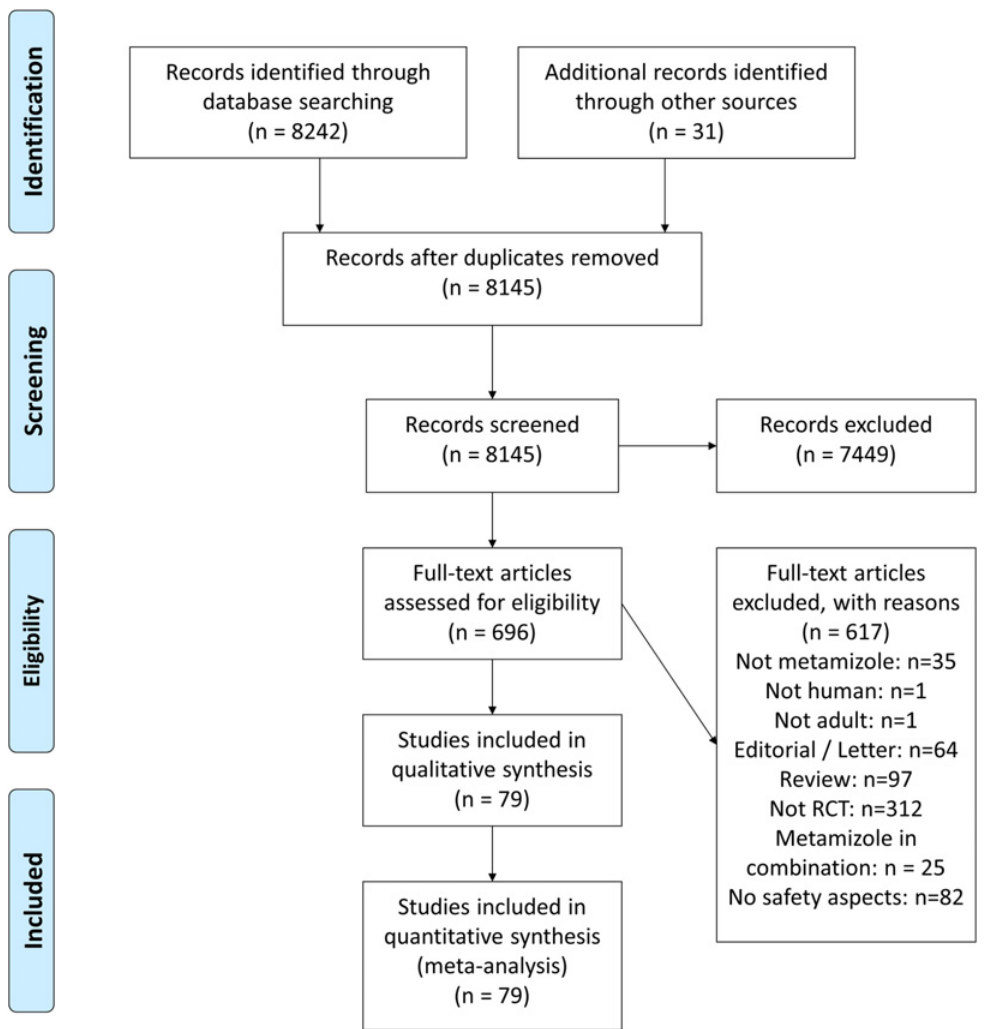
Fig 1. PRISMA flowchart. The 79 randomized controlled trials [18 – 95] assessed mainly short-term use of common analgesics. Forty-two trials (53%) investigated the use of only a single dose of metamizole. In addition, 18 trials (23%) had a maximum treatment duration of only one day, while in 17 trials treatment lasted from two days up to one week (22%) and only two trials (2%) had a treatment duration of two weeks. Average length of follow-up ranged from 0.33 to 366 hours (median: 24 hours). Four trials (5%) had sample sizes of at least 100 patients per randomized group (median: 30